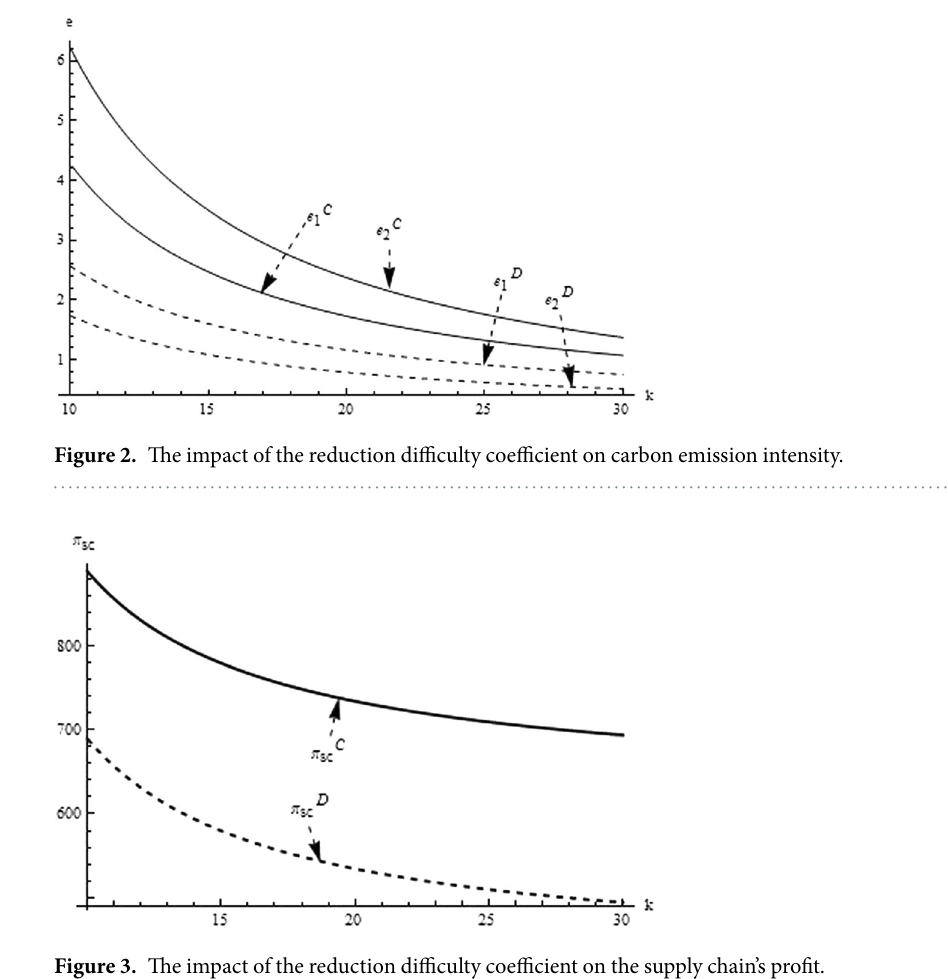
Figure 3. The impact of the reduction difficulty coefficient on the supply chain’s